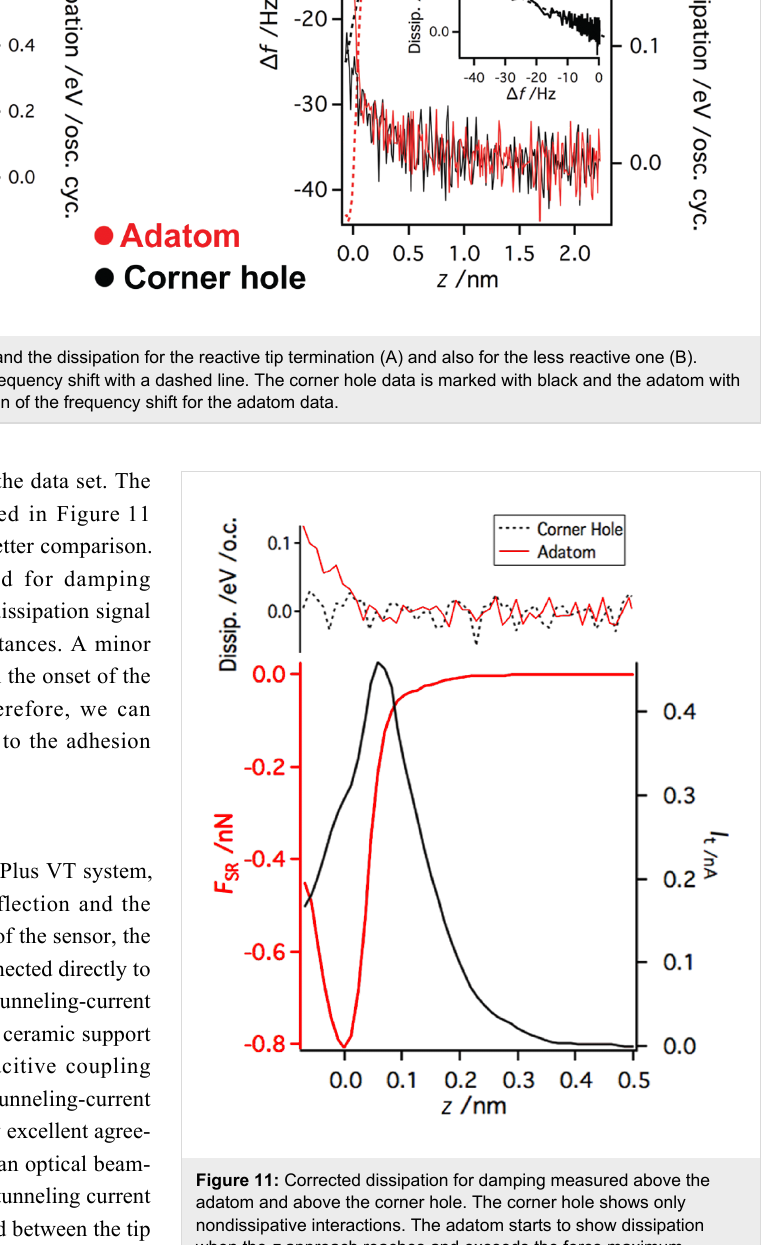
mentation and can be subtracted. The second one appears only above the adatom site after the tip approach exceeds the pos- ition of the maximum of the short-range attractive force. We attribute the second contribution to the adhesion hysteresis